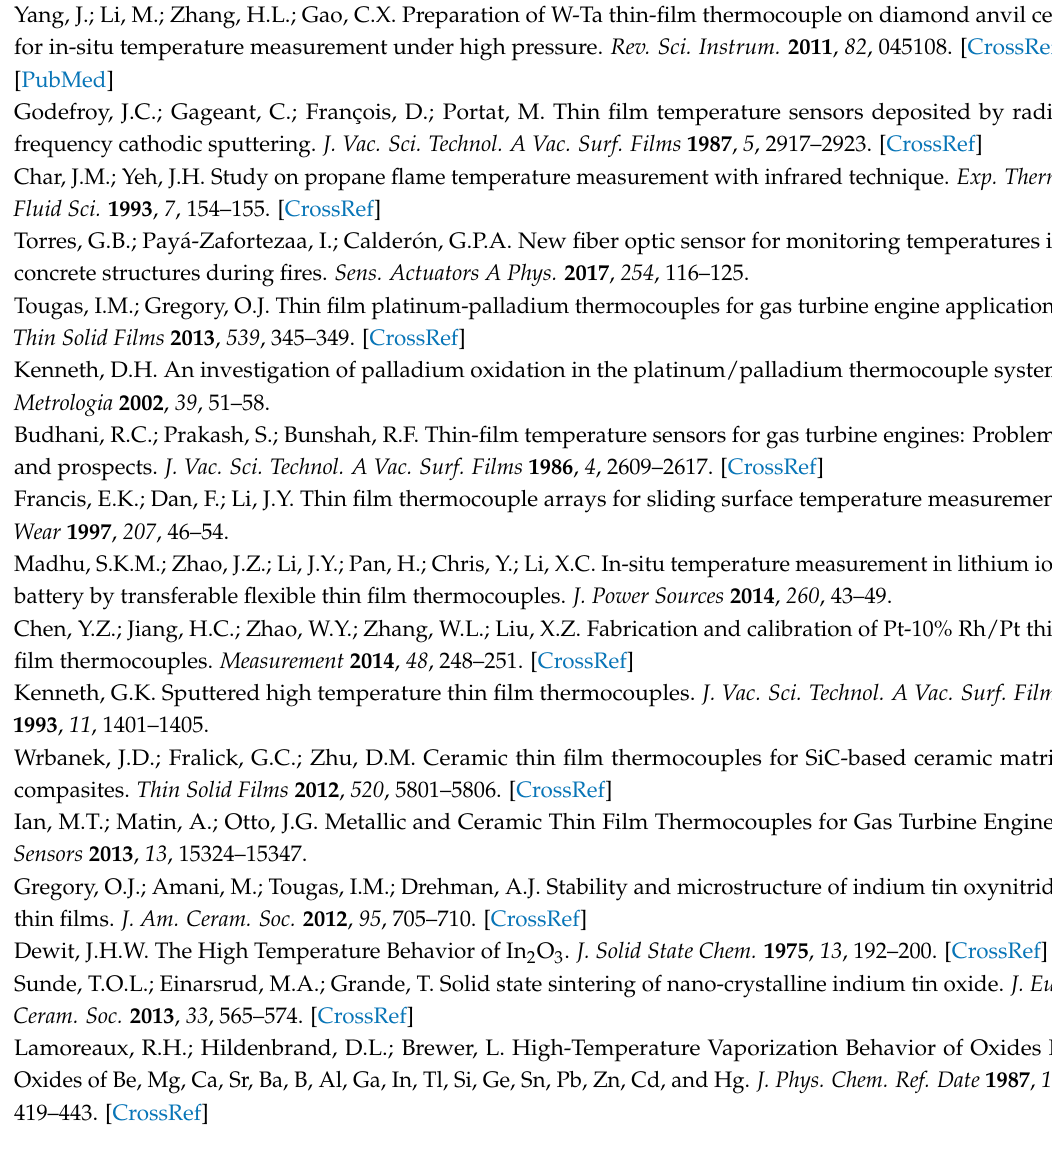
Figure S1: The temperature changes of the cold and hot junctions of thermocouple in the heating process, Figure S2: SEM surface images of ITO and In 2 O 3 films with different glass additives annealed at 1250 °C for 2 h. (A) ITO film, (B) In 2 O 3